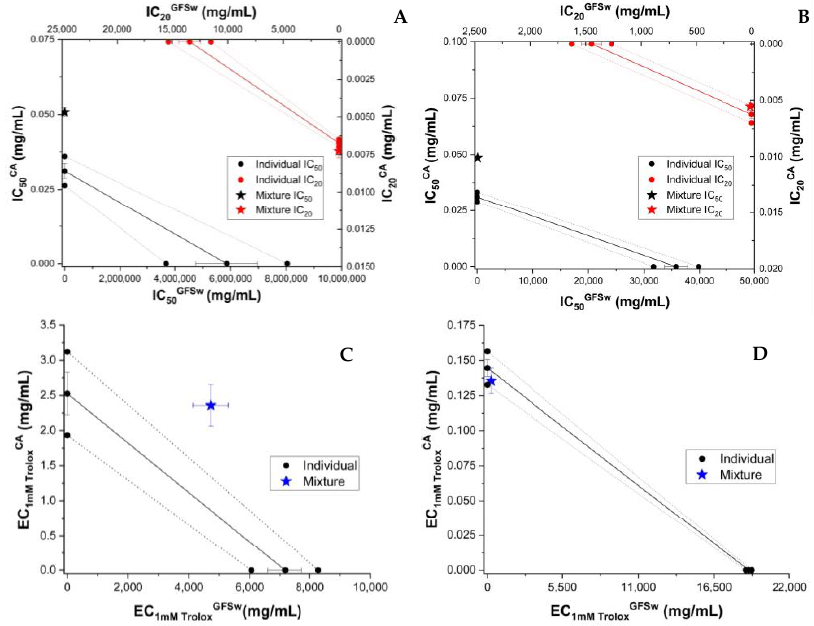
Figure 10. Isobolograms of NaDES (GFSw) and caffeic acid (CA) based on IC 50 (half-maximal inhibitory concentration) and IC 20 (inhibitory concentration at 20% substrate inhibition) for DPPH ( A ), and ABTS ( B ) methods, and based on EC 1mM Trolox (effective concentration at 1 mM Trolox equivalent of the samples) for CUPRAC ( C ) and FRAP ( D ) methods. The error bars from three measurements are shown for each value. Confidence intervals at 95% confidence are shown by dashed lines.